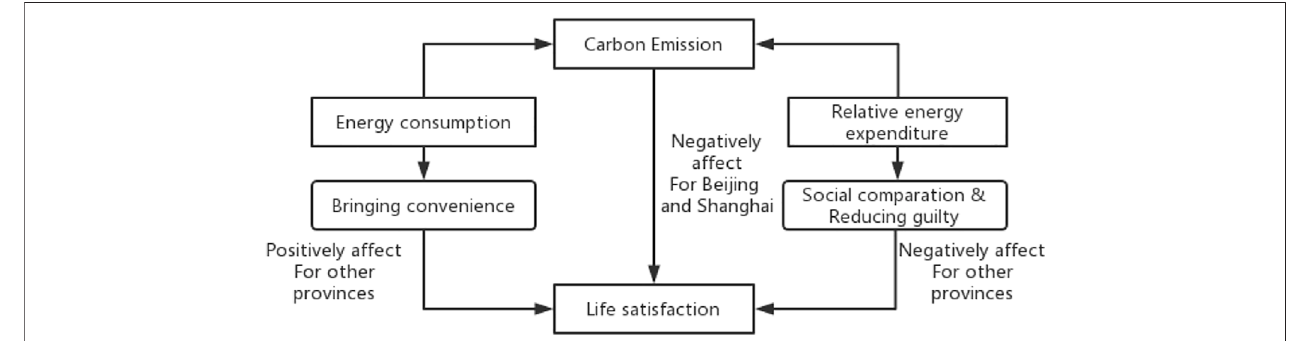
FIGURE 4 | Summary of the main fi